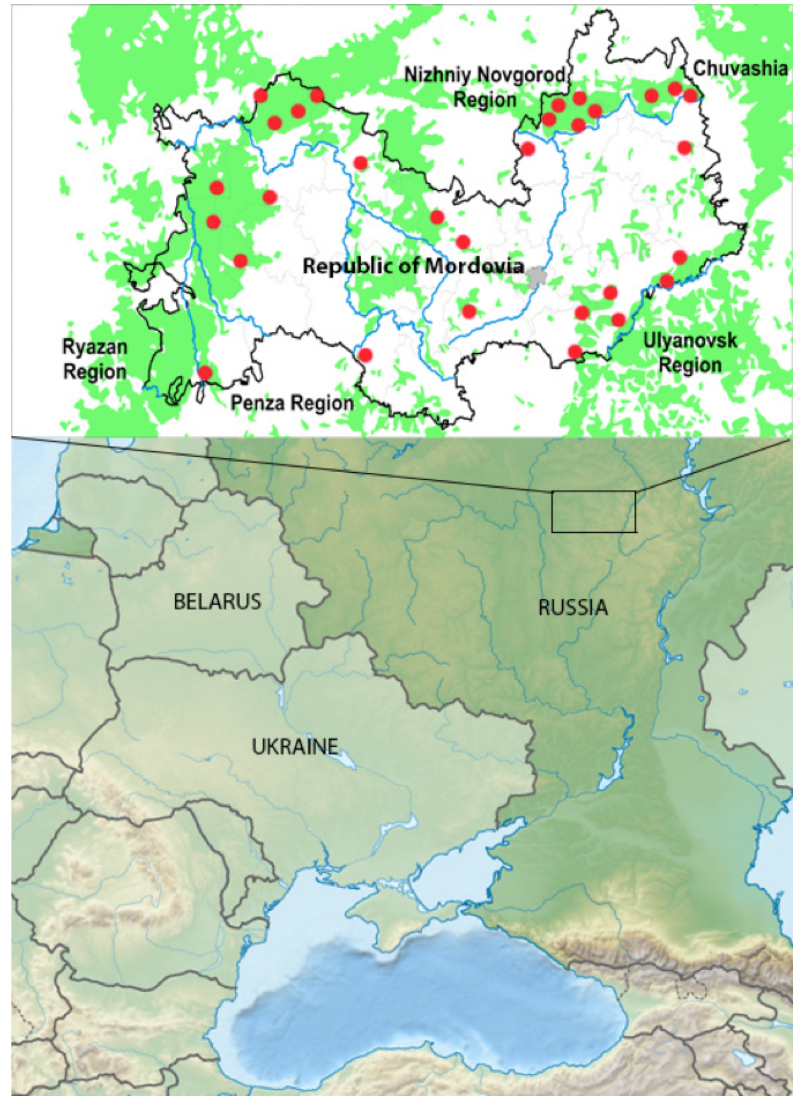
Figure 1. Places of finds of Clouded Apollo in the Republic of Mordovia (highlighted in